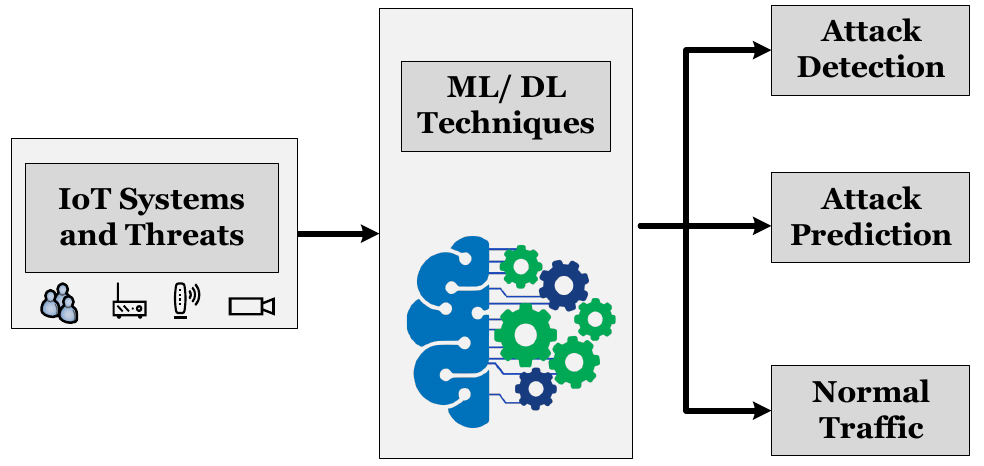
Figure 8. Role of Machine Learning/Deep Learning (ML/DL) Based IDS for IoT